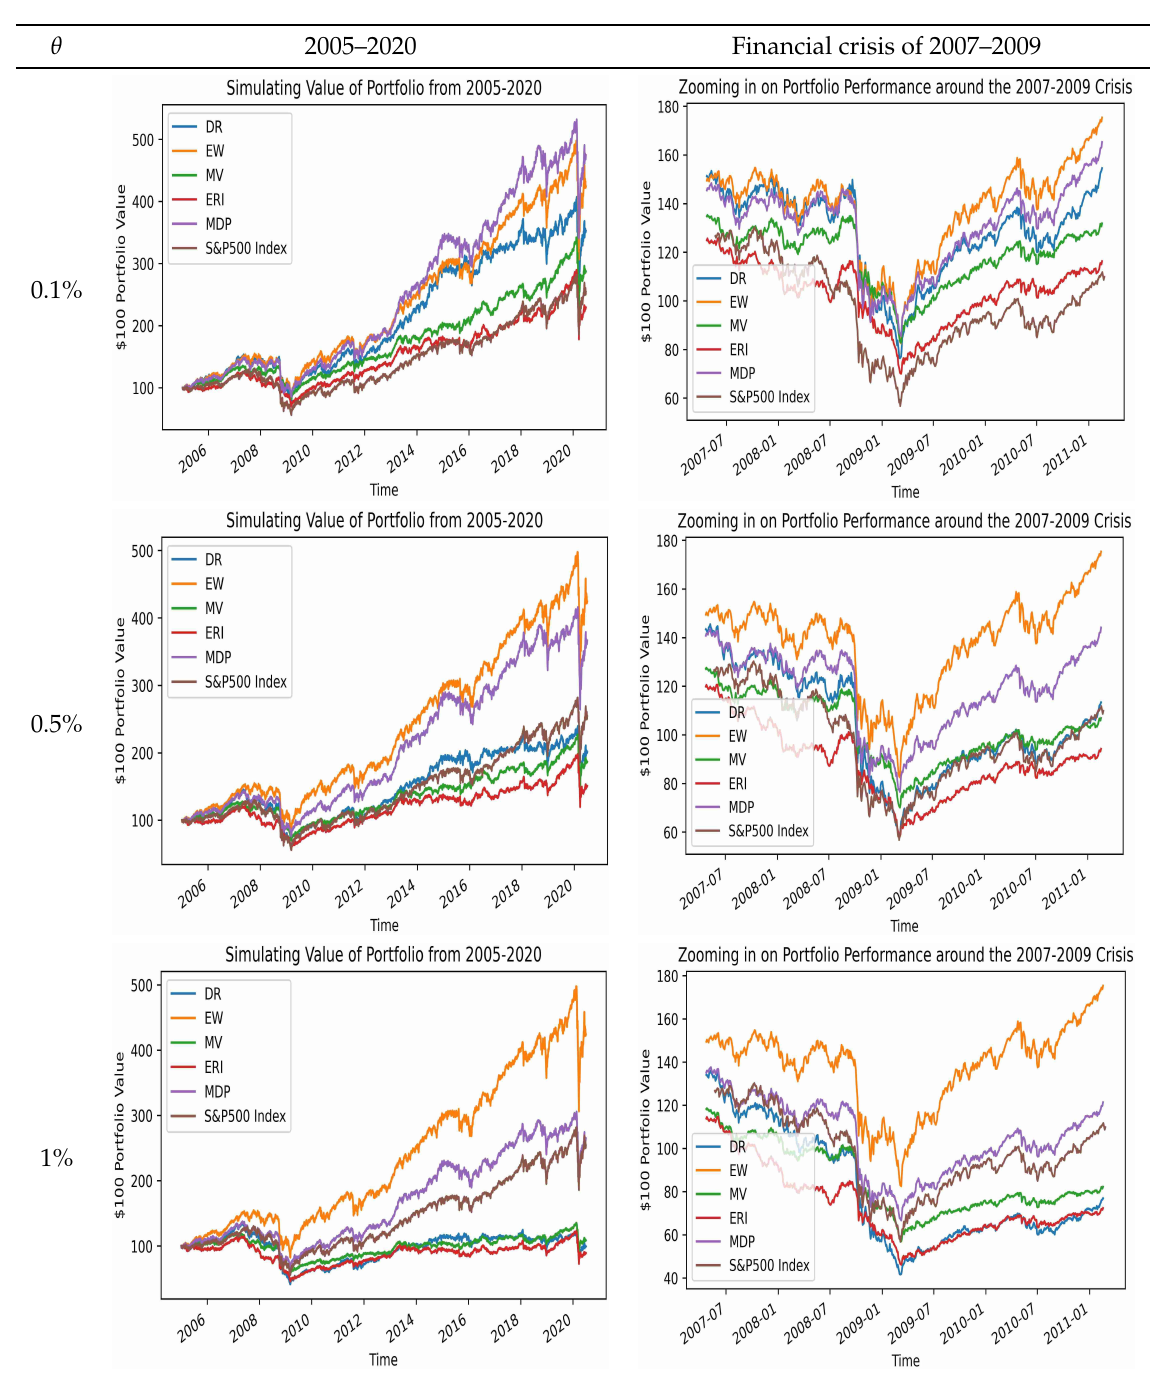
Figure A2. Portfolio values with transaction cost for grouped stocks with tail indices α ≤ 2.5 when θ = 0.1%,0.5%,1%, θ fc = 1.5 θ